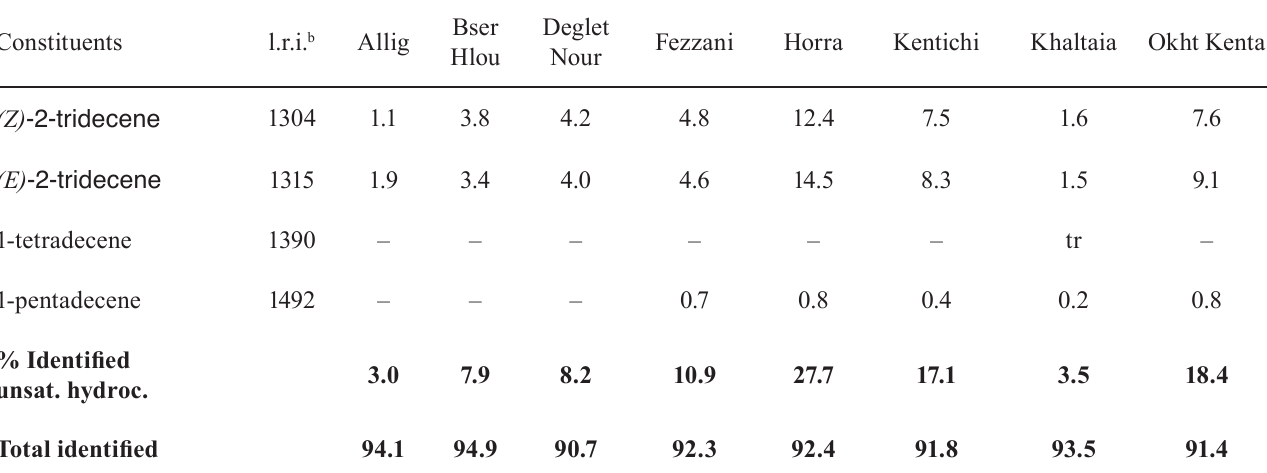
TABLE IV - Volatiles compositiona of date palm fruits obtained from eight varieties at Tamr stage (Cont.)